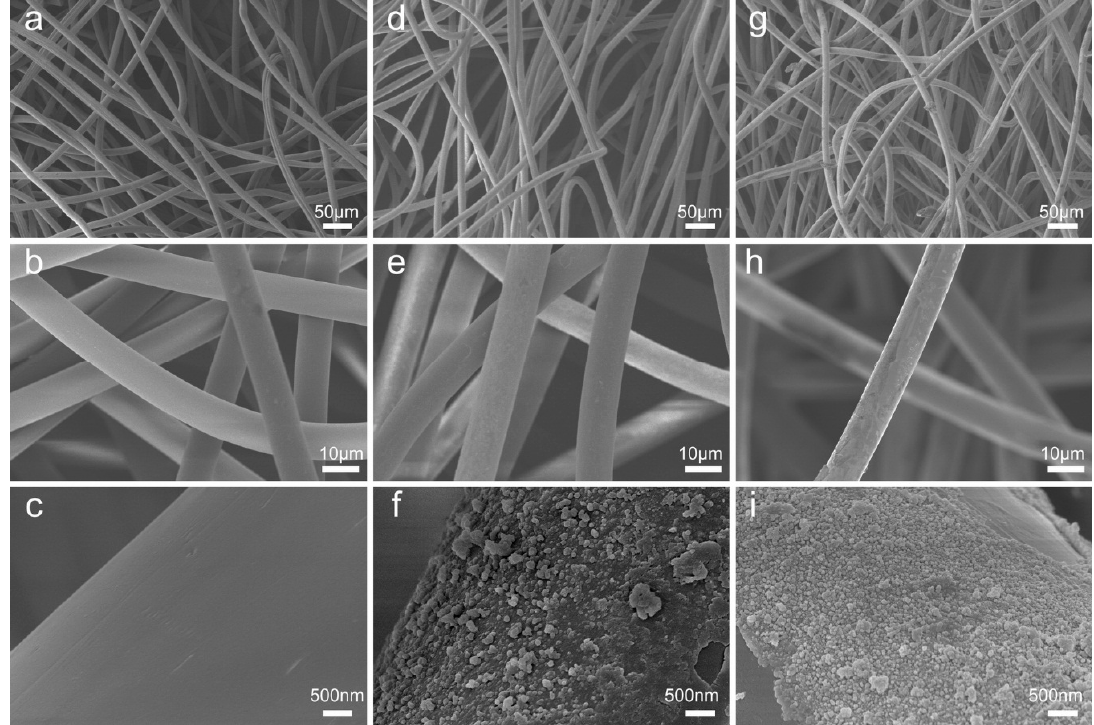
Figure 2. SEM images of the pristine non-woven (NW) fabrics ( a – c ), non-woven